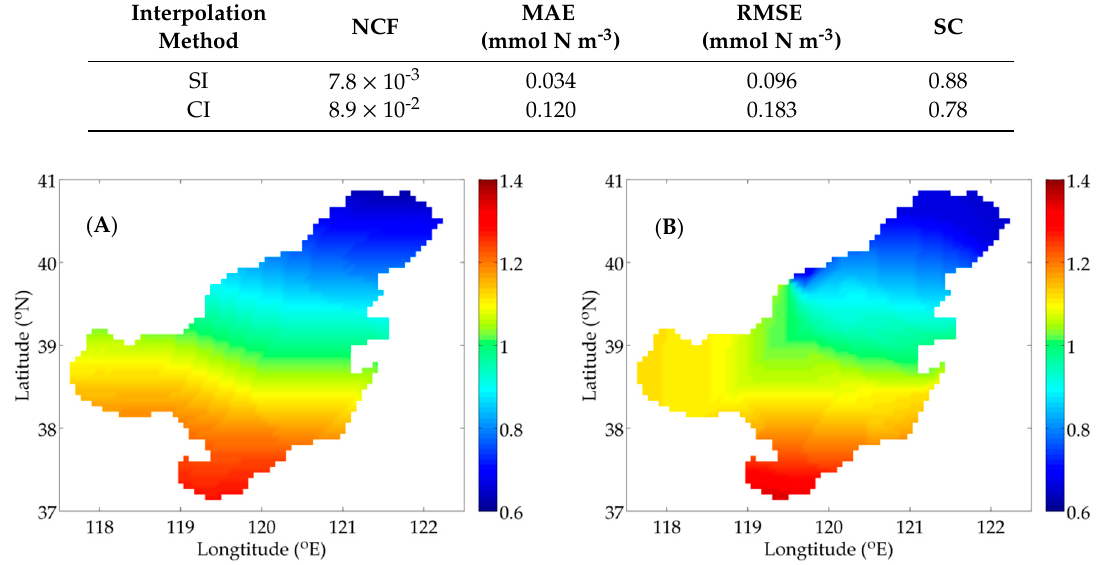
Figure 5. Distributions of P inverted with the adjoint method combined with SI ( A ); and CI ( B ) in IE2 (unit: mmol N m − 3 ).